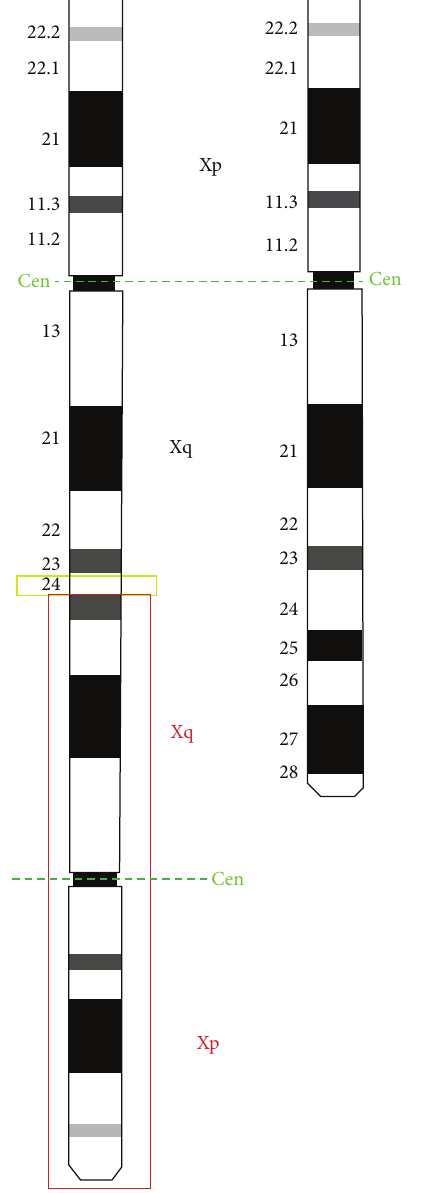
F 5: Comparison between reconstructed idiogram of the idic(X)(q24) and the normal